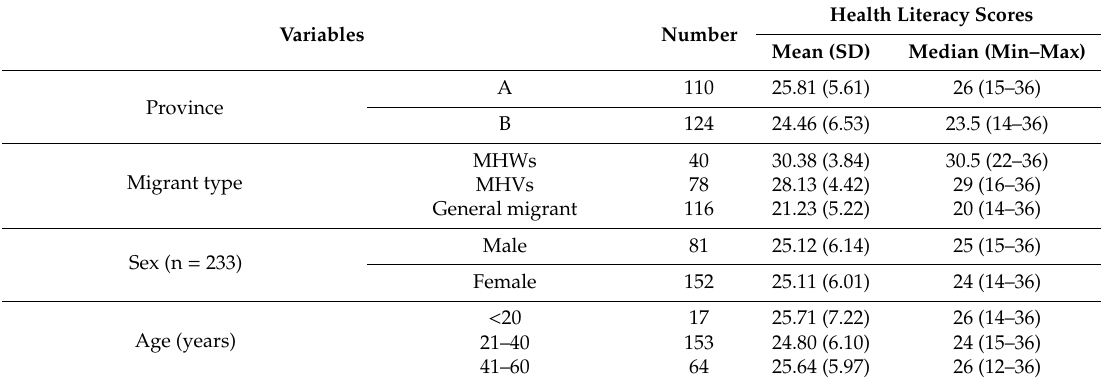
Table 1. Health literacy score of respondents classified by demographic